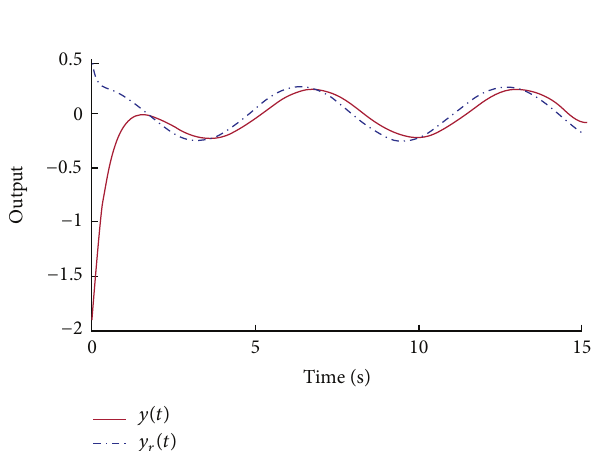
Figure 2: System output tracking trajectory with nonzero initial condition.